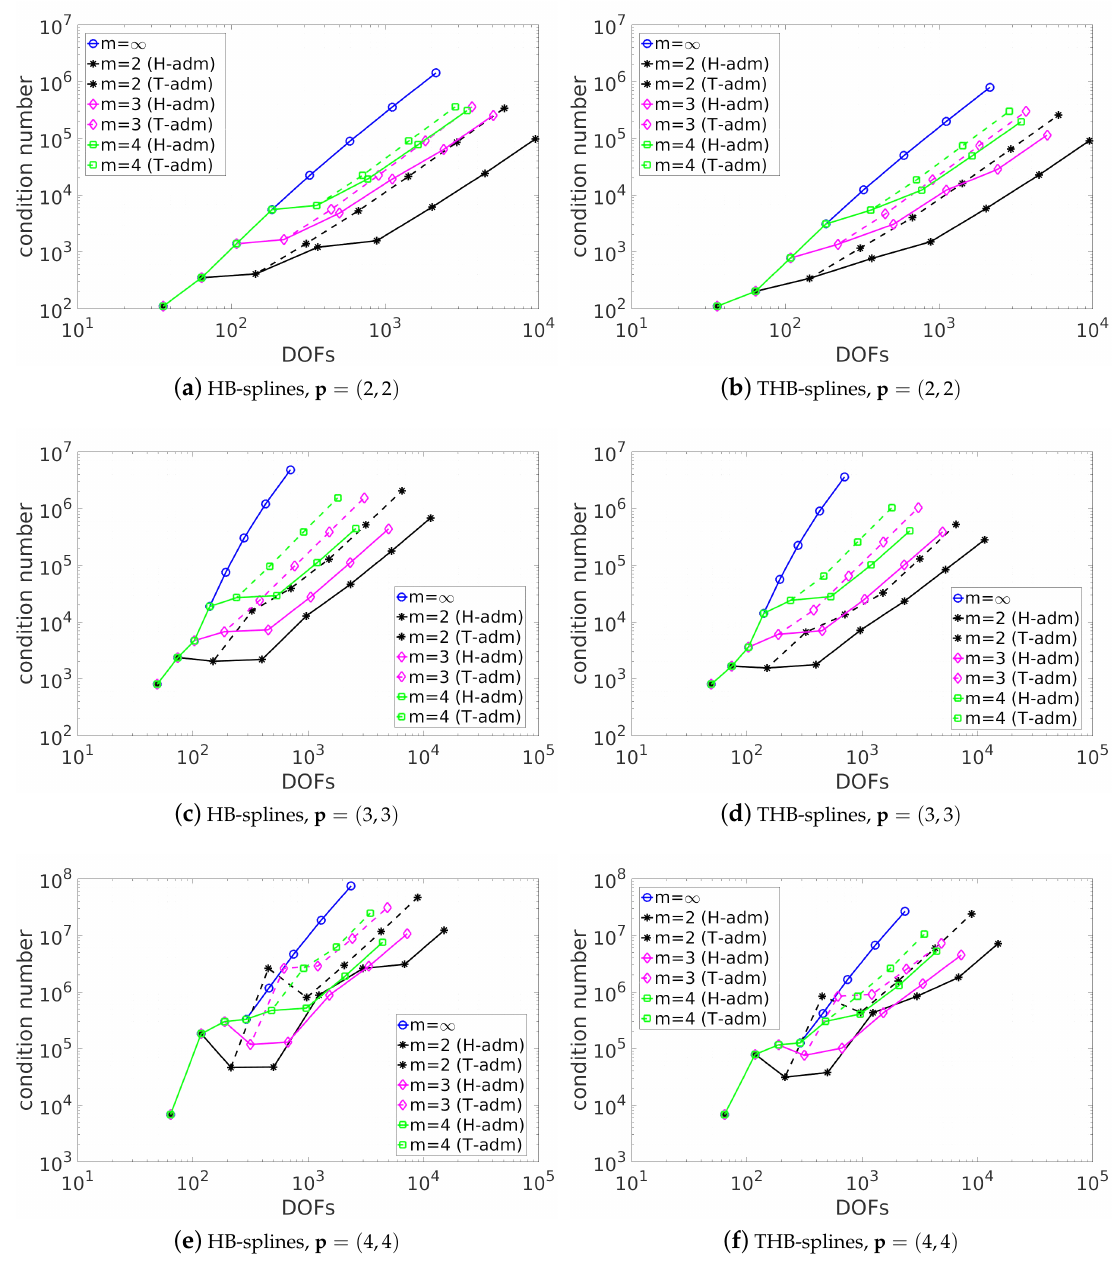
Figure 6. Condition numbers of the mass matrix for HB-splines and THB-splines, for different admissibility classes and different values of the